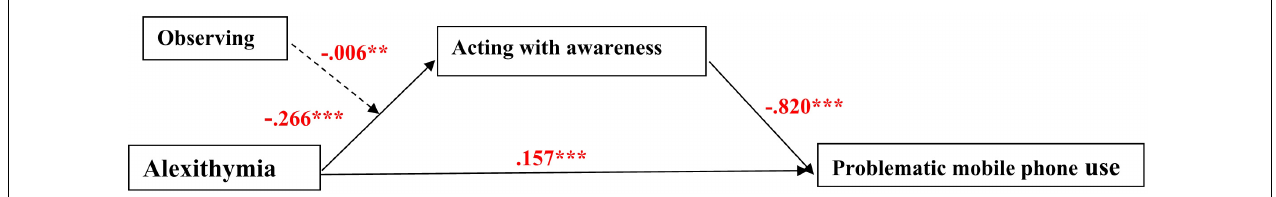
FIGURE 2 | The verified model of the moderated mediation effects between alexithymia and problematic mobile phone use ( N = 901). The study found that acting with awareness negatively mediated the association between alexithymia and problematic mobile phone use. Observing significantly moderated the impact of